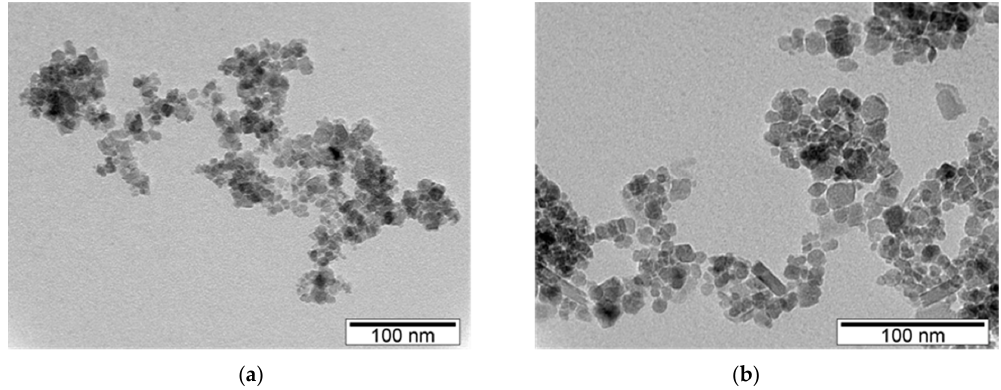
Figure 2. TEM micrographs of coated SPIONs: ( a ) C 1.1, ( b ) C 2.1. Table 3. Average (static) diameter and phase composition of naked and coated SPIONs .